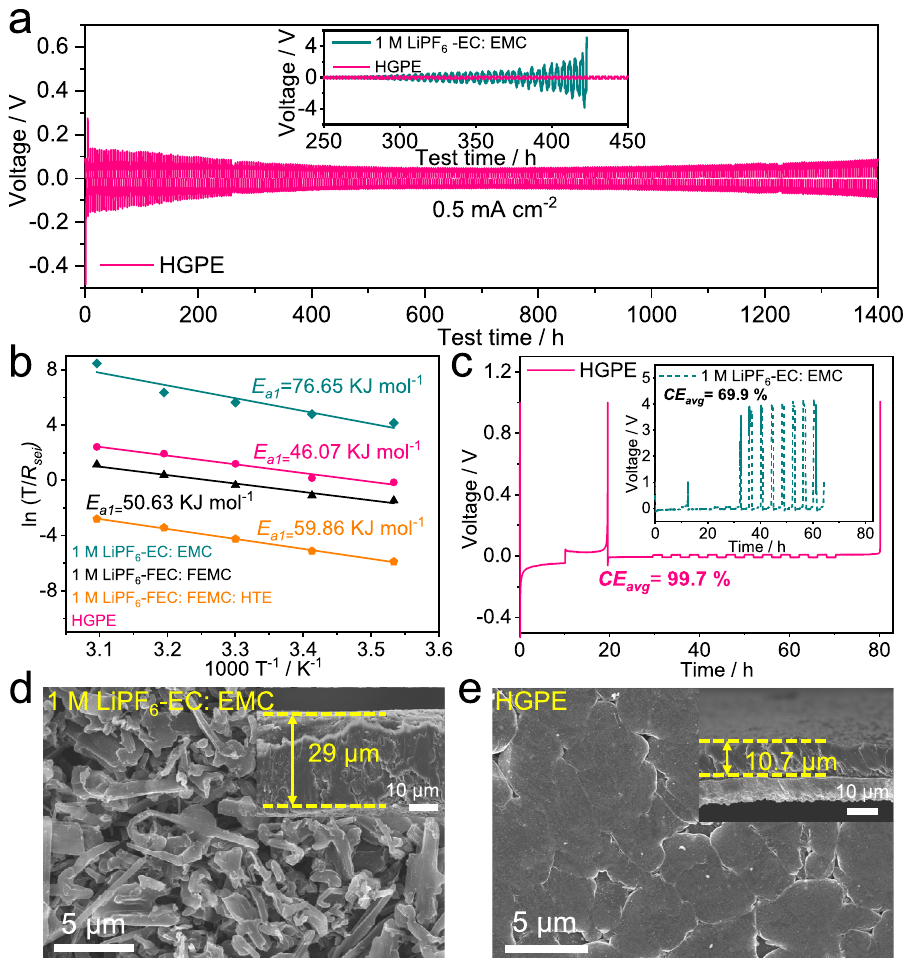
Fig. 3 Lithium plating/stripping behavior in various electrolyte formulations. a Voltage pro fi les of Li | |Li symmetric cells using 1 M LiPF 6 -EC: EMC electrolyte (shown in inset) and HGPE at 0.5 mA cm − 2 with a cutoff capacity of 1 mAh cm − 2 ; b The activation energies of R sei derived from Nyquist plots; c CE avg tests of Li plating-stripping in Li|1 M LiPF 6 -EC: EMC | Cu (shown in inset) and Li|HGPE | Cu cells at 0.5 mA cm − 2 with a capacity of 1 mAh cm − 2 ; d , e Top and cross-sectional (shown in inset) FE-SEM images of the Li deposition obtained by plating 1 mAh cm − 2 Li on Cu substrate at 0.2 mA cm − 2 in Li | |Cu cells using d 1 M LiPF 6 -EC: EMC electrolyte and e HGPE. Scale bars: 5 μ m in Fig. 3d, e; 10 μ m in the inset of Fig. 3d,